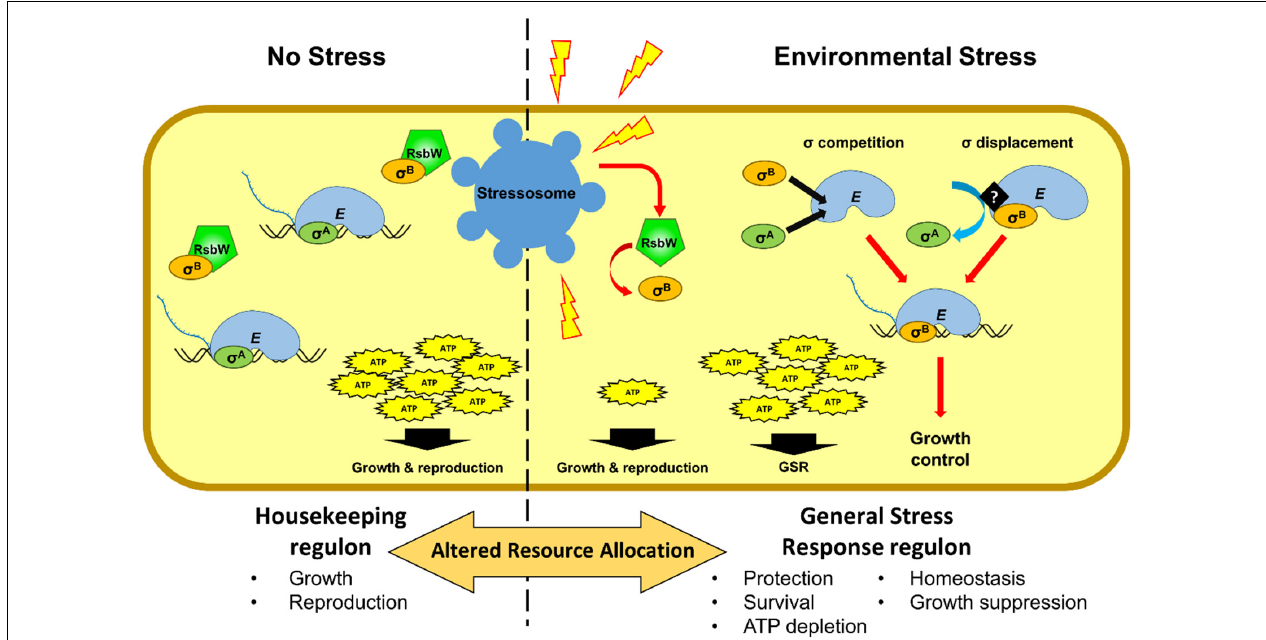
FIGURE 2 | Schematic representation of the alterations in resource allocation that occur during the GSR. Cell growth largely depends on the housekeeping sigma factor σ A in the absence nutrient limitations or stressful conditions. Under these conditions (no stress), most of the transcriptional machinery is dedicated to the transcription of housekeeping genes that preceded by σ A promoters. In the absence of stress, σ B is sequestered by the anti-sigma factor RsbW. At the onset of stress σ B is released from its anti-sigma factor RsbW, resulting in competition between σ B and σ A and the displacement of σ A from a proportion of the RNA polymerase pool. It is possible that the interaction of σ B with RNA polymerase is specifically regulated as has been described in other species. Consequently, genes under σ A control that are associated with growth functions are downregulated and σ B dependent genes (the GSR regulon) are upregulated. The energy resources needed to maintain the general stress response reduces the availability of ATP for growth and reproduction. σ B may specifically regulate growth rate to allow for improved maintenance and repair, thereby increasing the likelihood of